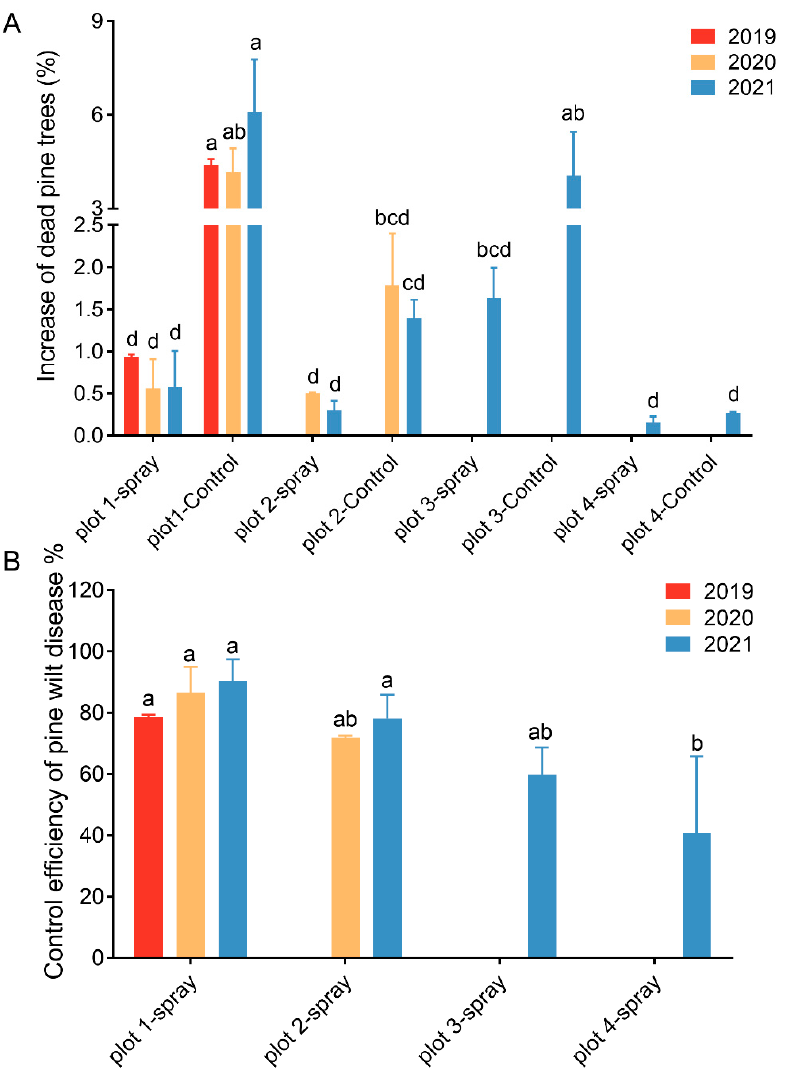
Figure 6. Preventative effect of fluopyram suspension concentrate in the pine forest. Increase in dead pine trees (%) ( A ) and control efficiency of pine wilt disease (%) ( B ) in three sample plots in 2019, 2020, and 2021. Bars with different letters indicate statistical significance at p < 0.05.